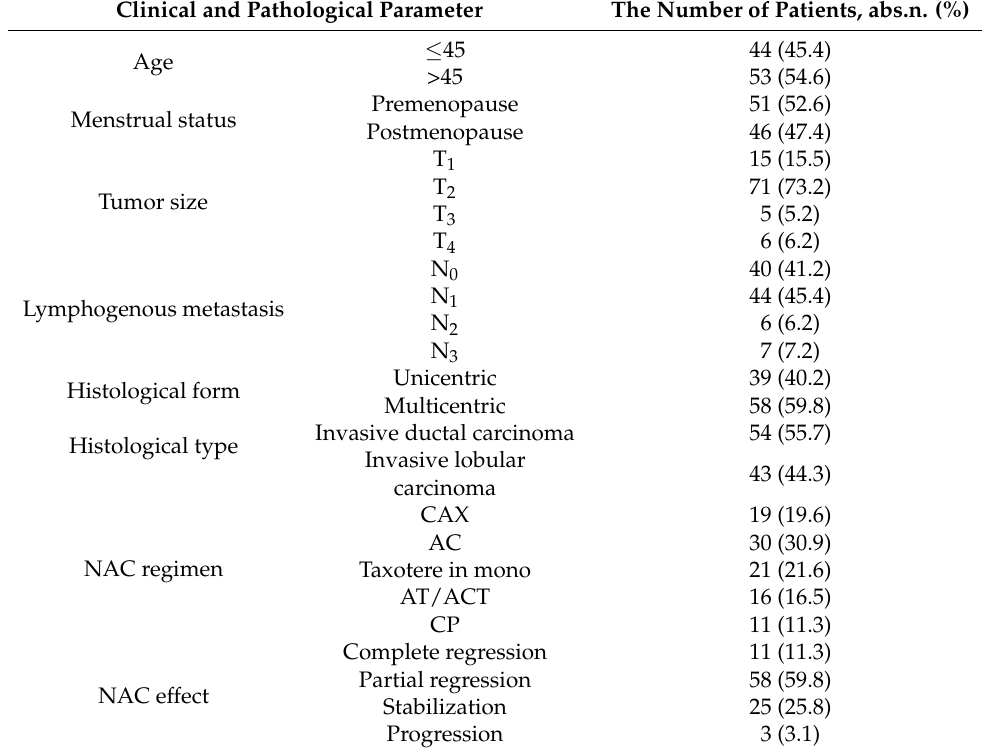
Table 1. The main clinical and pathological parameters of patients. Clinical and Pathological Parameter The Number of Patients, abs.n.